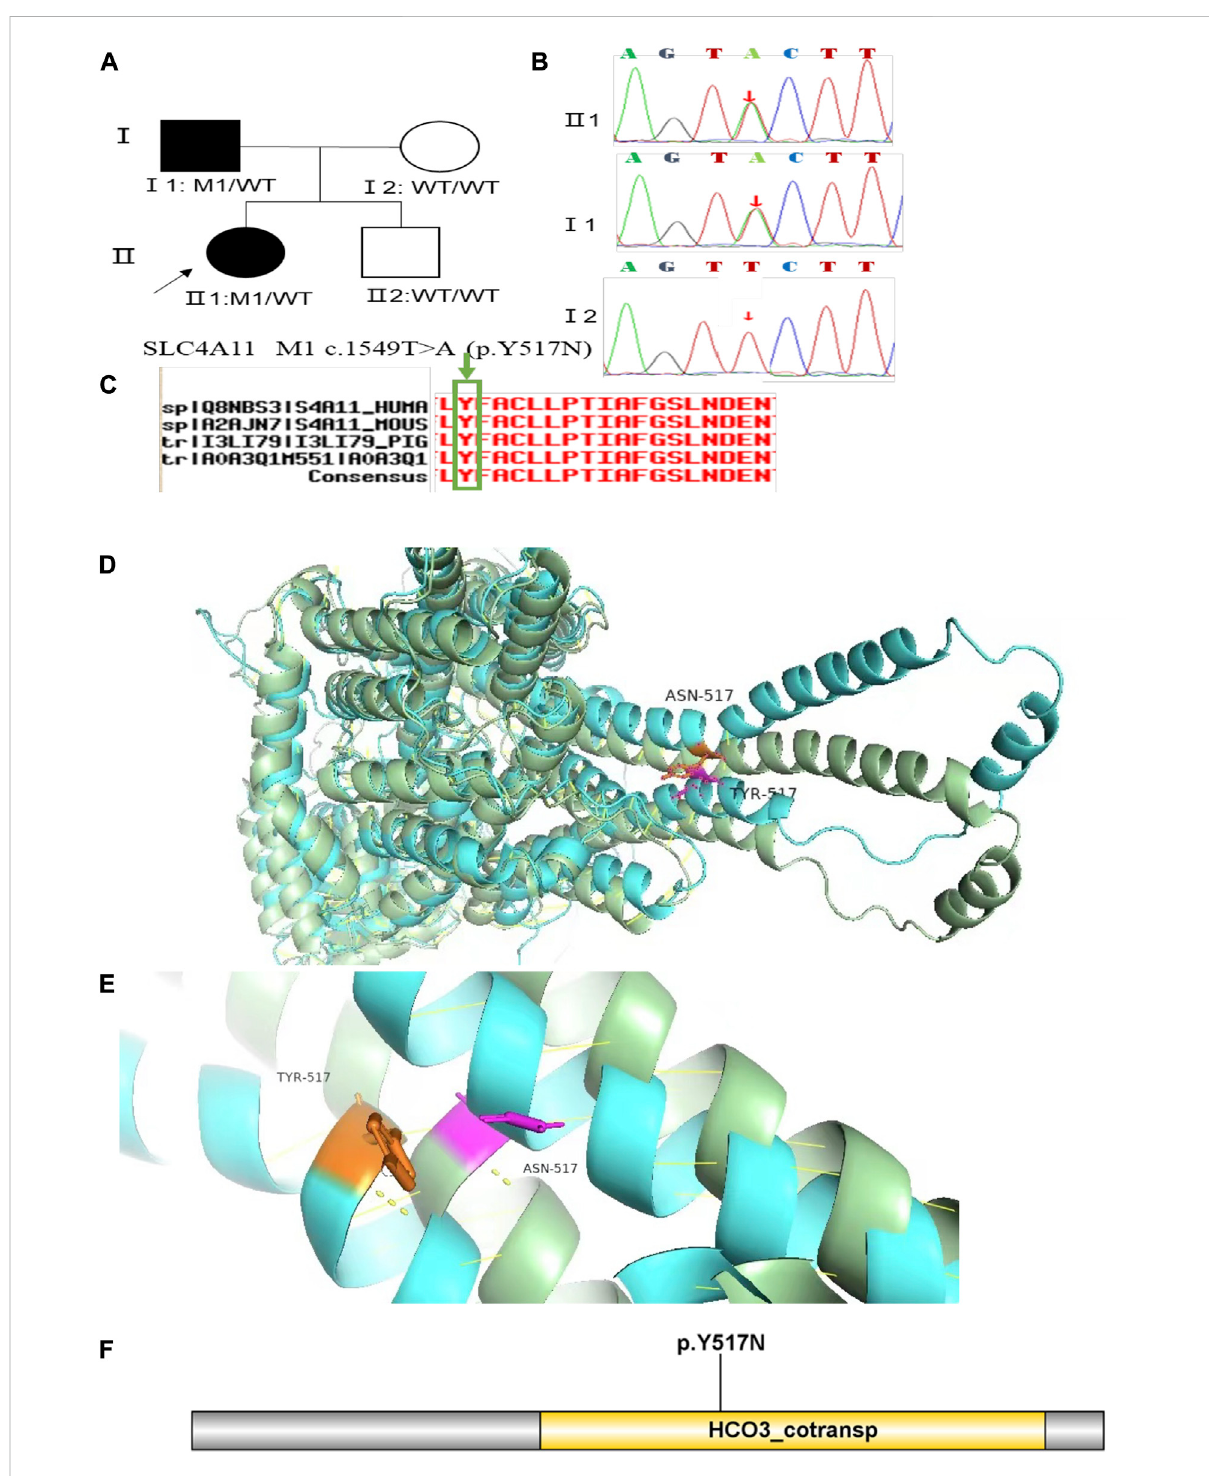
FIGURE 6 Sequence analysis and identi fi cation of the novel variant of SLC4A11 in the affected Chinese family with autosomal-dominant KC. (A) Pedigree of the family. The fi lled black symbols represent the affected members, and the arrow denotes the proband. (B) By sequencing analysis, a heterozygous variant of (C) 1549T > A was identi fi ed in the affected individuals of II:1 and I:1. (C) The homology of amino acid sequences between human SLC4A11 and other species. The amino acid at position 517 (Tyrosine, Y517) is highly conserved among species (green box). (D,E) Homology model of the Solute carrier family 4 members 11 (green). (F) Structural modelling of Solute carrier family 4 members 11